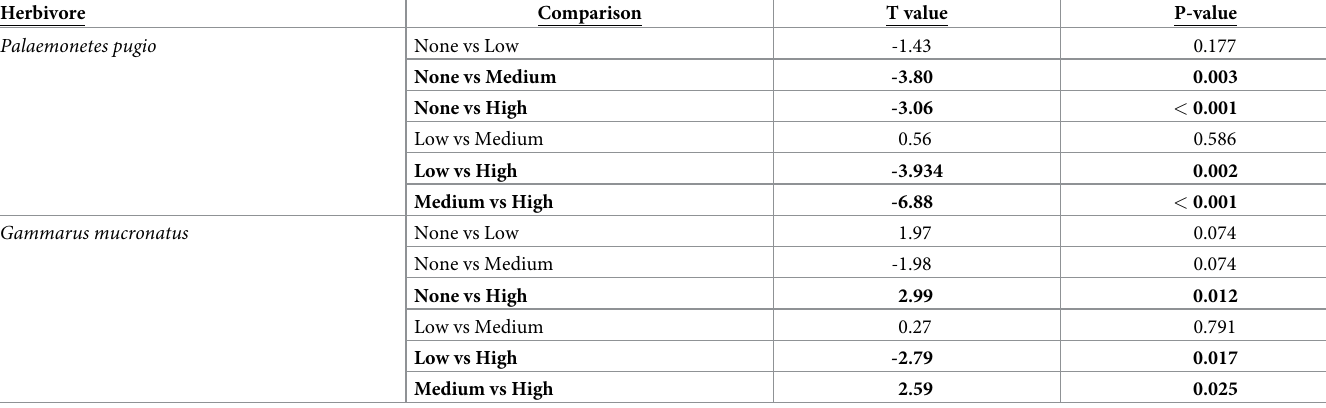
Table 1. Results from paired t-tests comparing herbivore preference patterns in Experiment 2 among plants with no (0 mL oil/L tank), low (0.26 mL oil/L tank vol- ume), medium (0.53 mL oil/L tank volume), and high (1.05 mL oil/L tank volume) oil exposure. Significant results (p < 0.05) are shown in bold. Herbivore